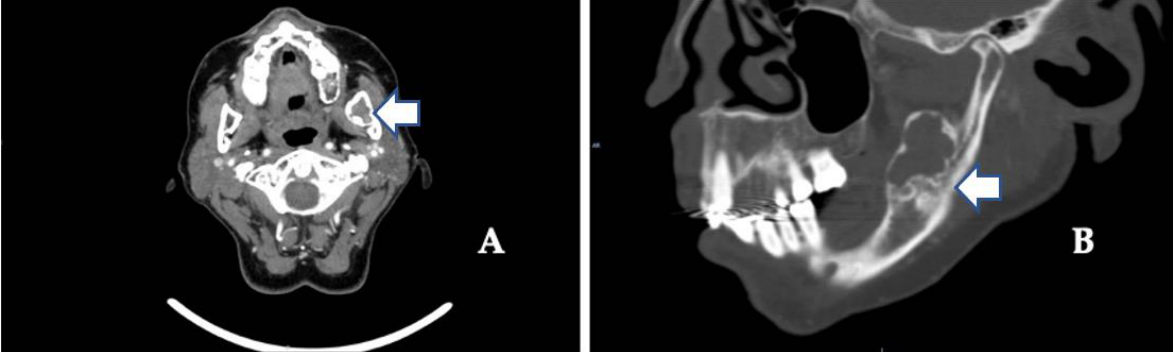
Figure 2. ( A ) Contrast-enhanced computed tomography scan showing the extent of the tumor along the mandibular angle (see arrow) (coronal image). ( B ) Sagittal view shows mixed radiolucent– radiopaque lesions (see arrows) and advanced osteoarthritic changes in the left temporomandibular joint (see arrow).